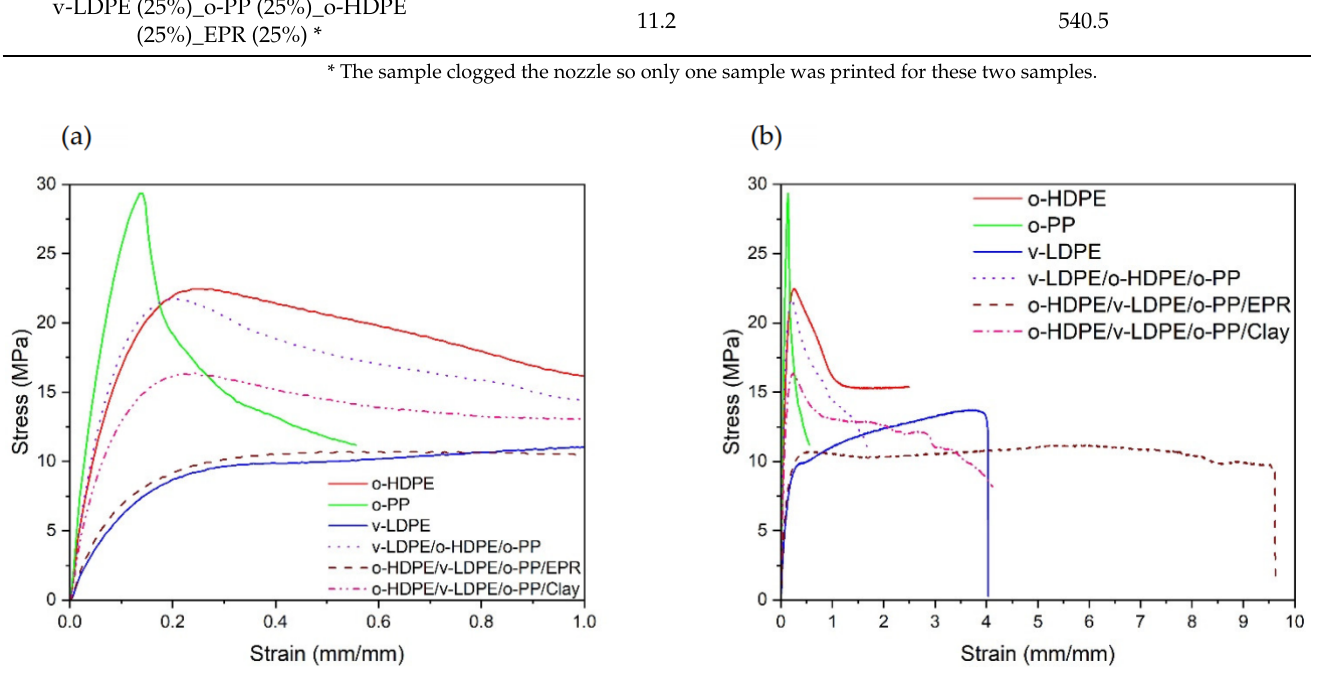
Figure 4. Mechanical properties of polymer blends made of ocean-bound plastic waste with a strain of ( a ) 0–1 mm/mm and ( b ) 0–10 mm/mm.